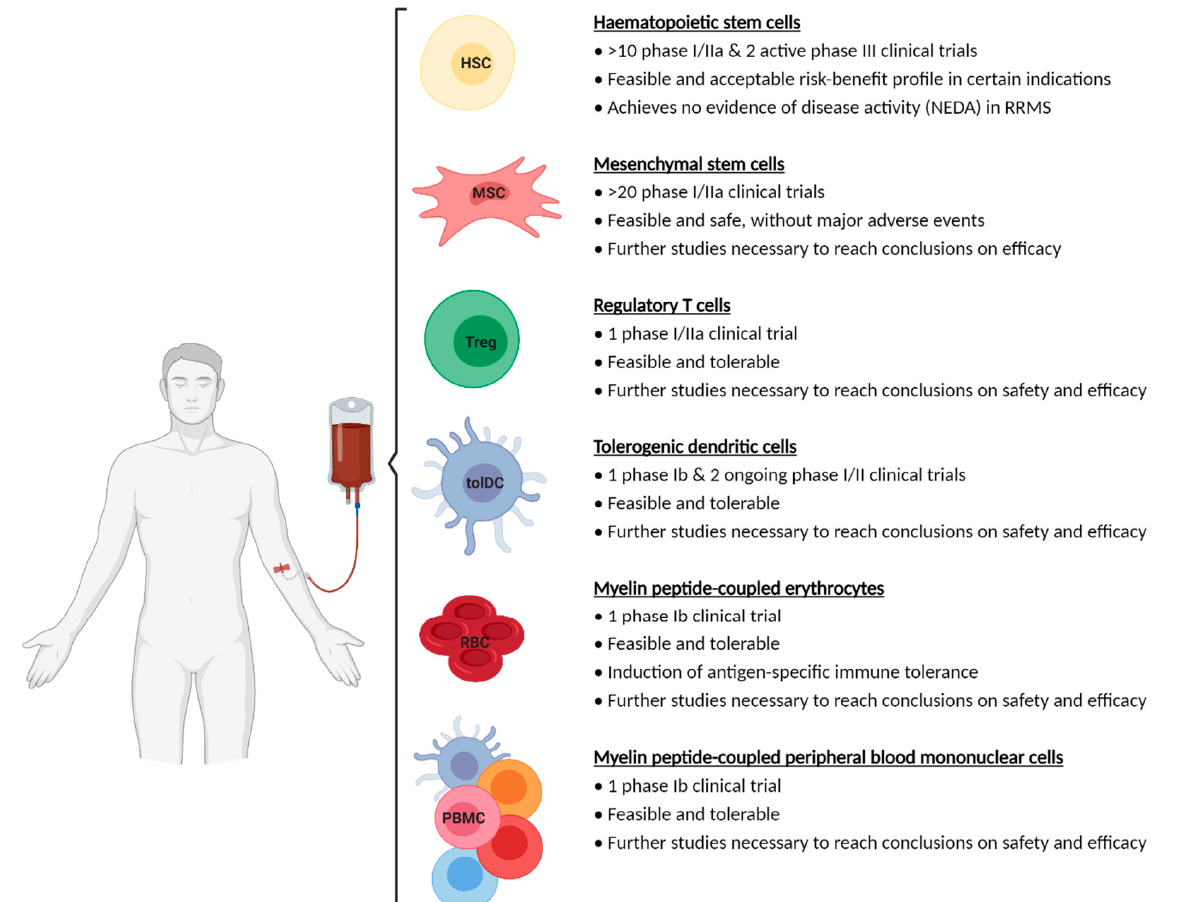
Figure 2. Schematic overview of current cell-based tolerance-inducing treatments for multiple sclerosis (MS) in the clinic. Summary of the results on the feasibility, tolerability, safety and efficiency of cell-based tolerance-inducing treatments that are currently being investigated in different clinical trials is given. Abbreviations used: HSC: haemopoietic stem cells; MSC: mesenchymal stromal cells; PBMC: peripheral blood mononuclear cells; RBC: erythrocytes; Treg: regulatory T cells; tolDC: tolerogenic dendritic cells. Created with BioRender.com, accessed date 13 July 2021 .